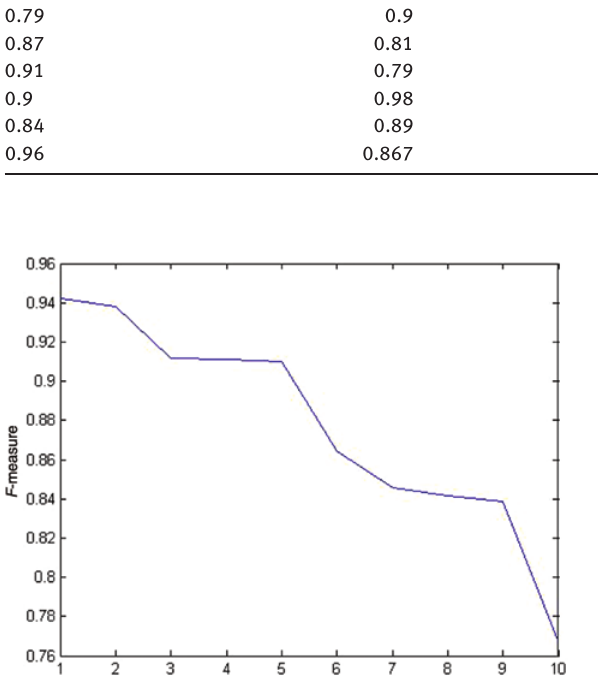
Figure 7: F -measure Evaluation.